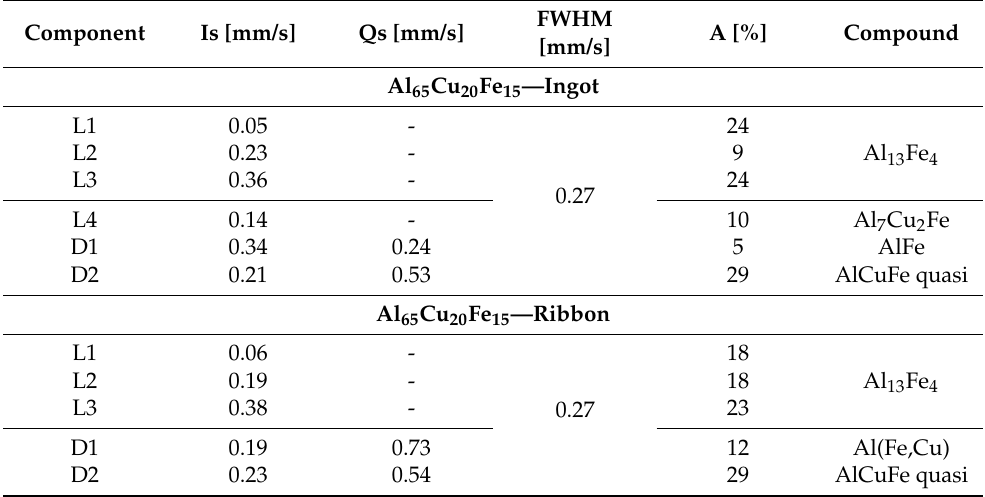
Table 1. The Mössbauer hyperfine parameters of the investigated samples. Isomer shift (Is), quadrupole splitting (Qs), full width at half maximum (FWHM), and relative area from the spectra (A) for the studied